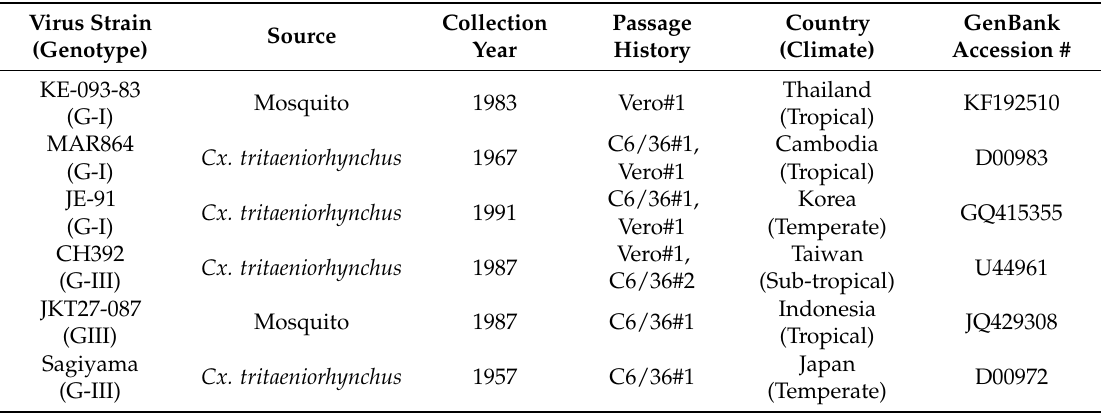
Table 1. Japanese encephalitis viruses utilized in the